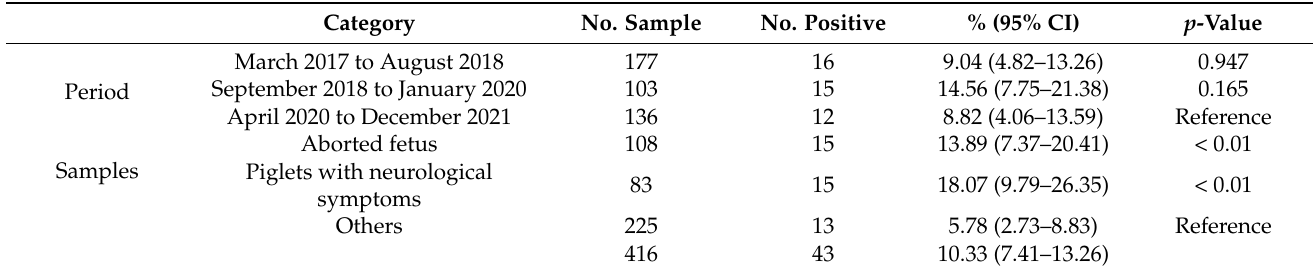
Table 3. The PRV-gE DNA positive rates among pigs with different risk